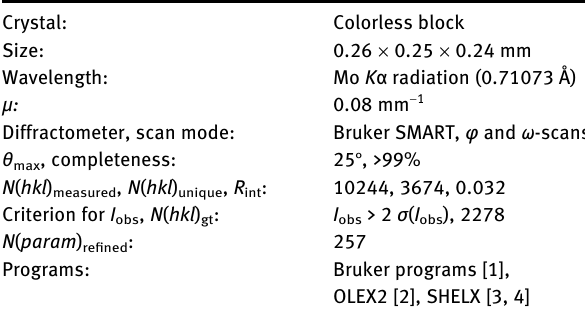
Table  : Data collection and